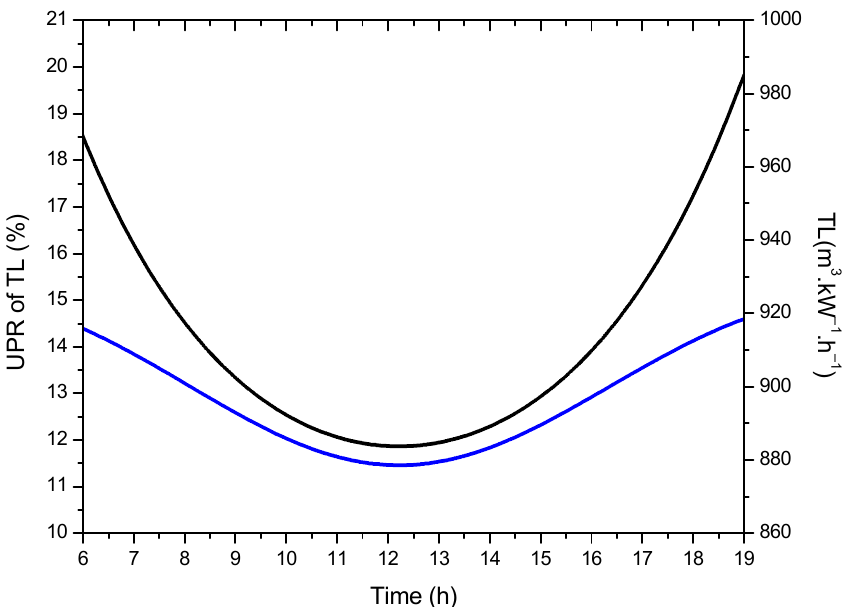
Figure 8. Variation of UPR% of thermodynamic limit and the thermodynamic limit over the local time.